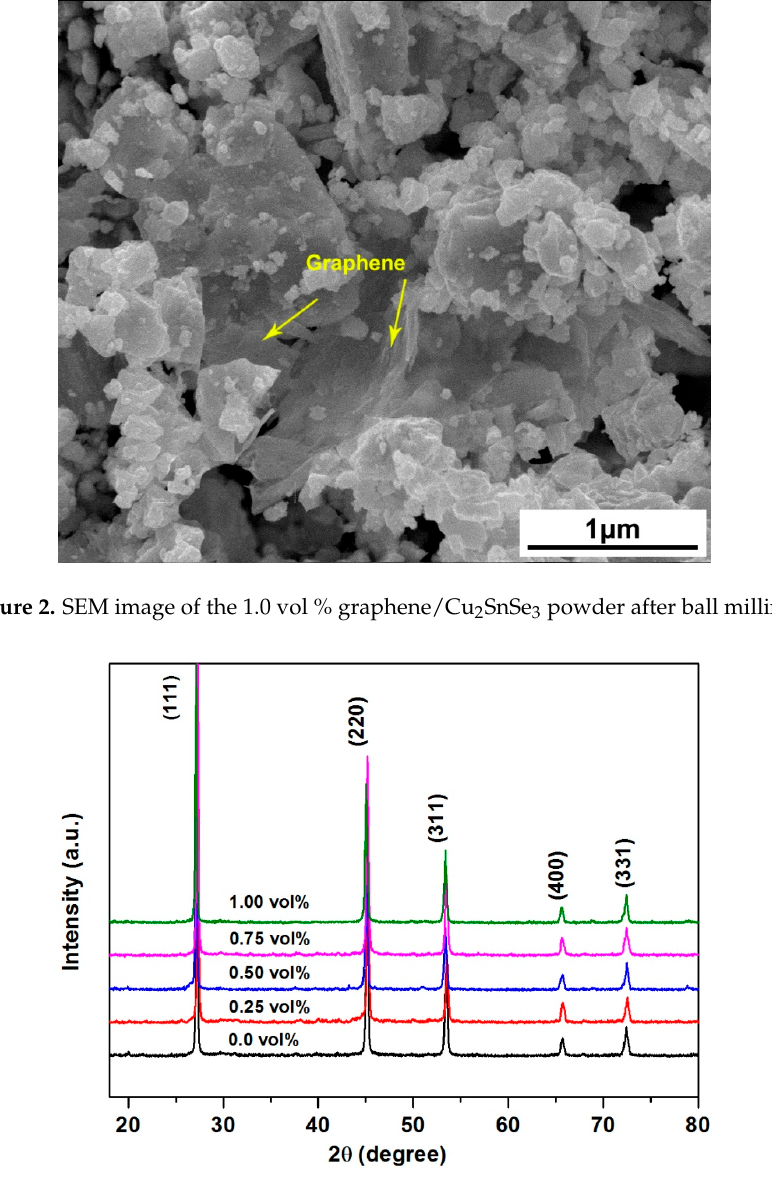
Figure 3. XRD patterns of sintered graphene/Cu 2 SnSe 3 samples.